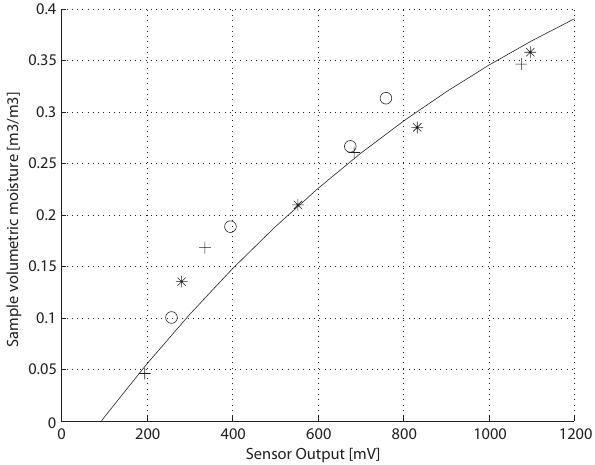
Fig. 6. 5TE sensor output [mV] against volumetric moisture con- tent [m 3 m − 3 ] derived from surface soil samples (0–5cm depth) of agricultural land (o), forest (+) and heath ( ∗ ) (composite classes 212/ASS, 512/FSS and 612/HSS, respectively) including the Decagon 5TE default calibration curve.